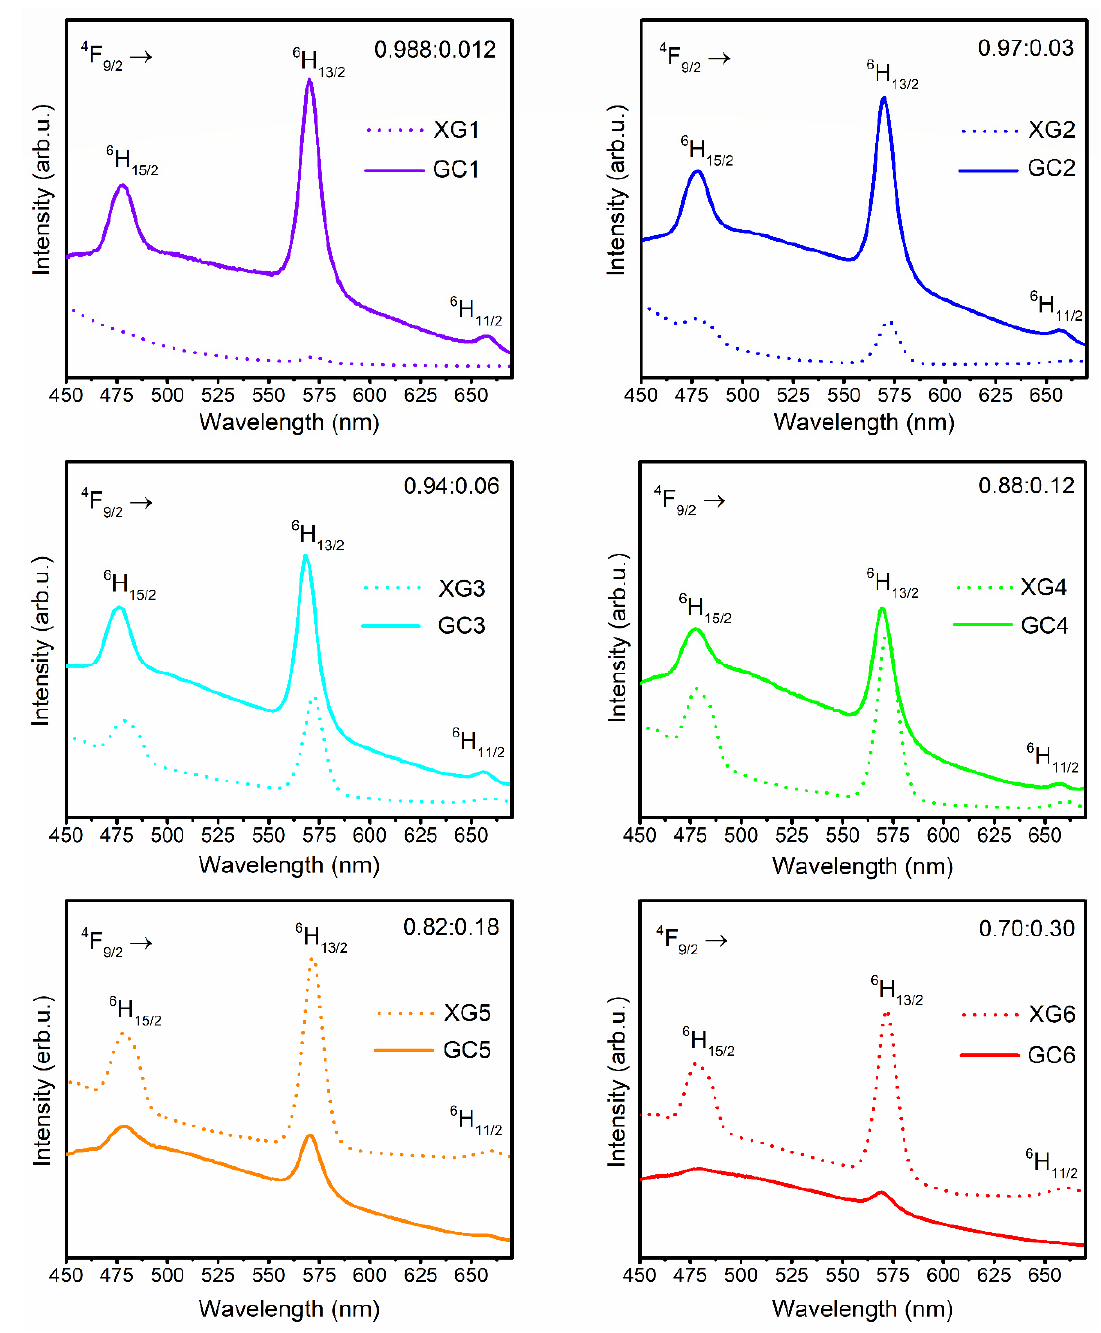
Figure 9. The comparison of emission spectra for xerogels and nano-glass-ceramic materials for individual La 3+ :Dy 3+ molar ratios.